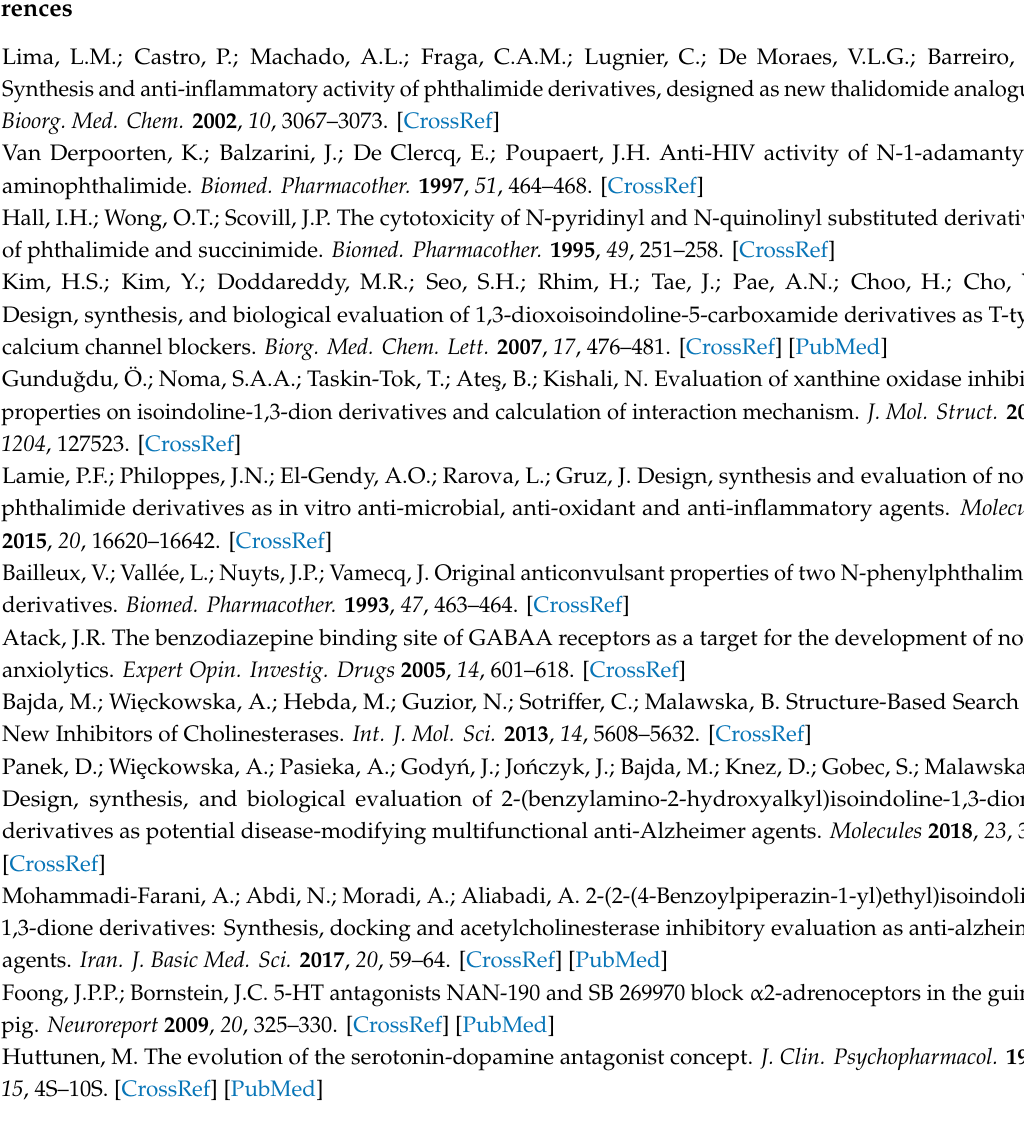
Supplementary Materials: The following are available online, Figure S1: The spider graph of drug-like parameters of compound 18 , Figure S2. E ff ects of papaverine and compound 18 on d-amphetamine-induced hyperlocomotor activity in CD-1 mice, Table S1: E ff ects of papaverine and compound 18 on spontaneous locomotor activity in CD-1 mice, Table S2. Detailed conditions of the in vitro binding assays for the 5-HT 1A and 5-HT 7 receptors and examples of NMR